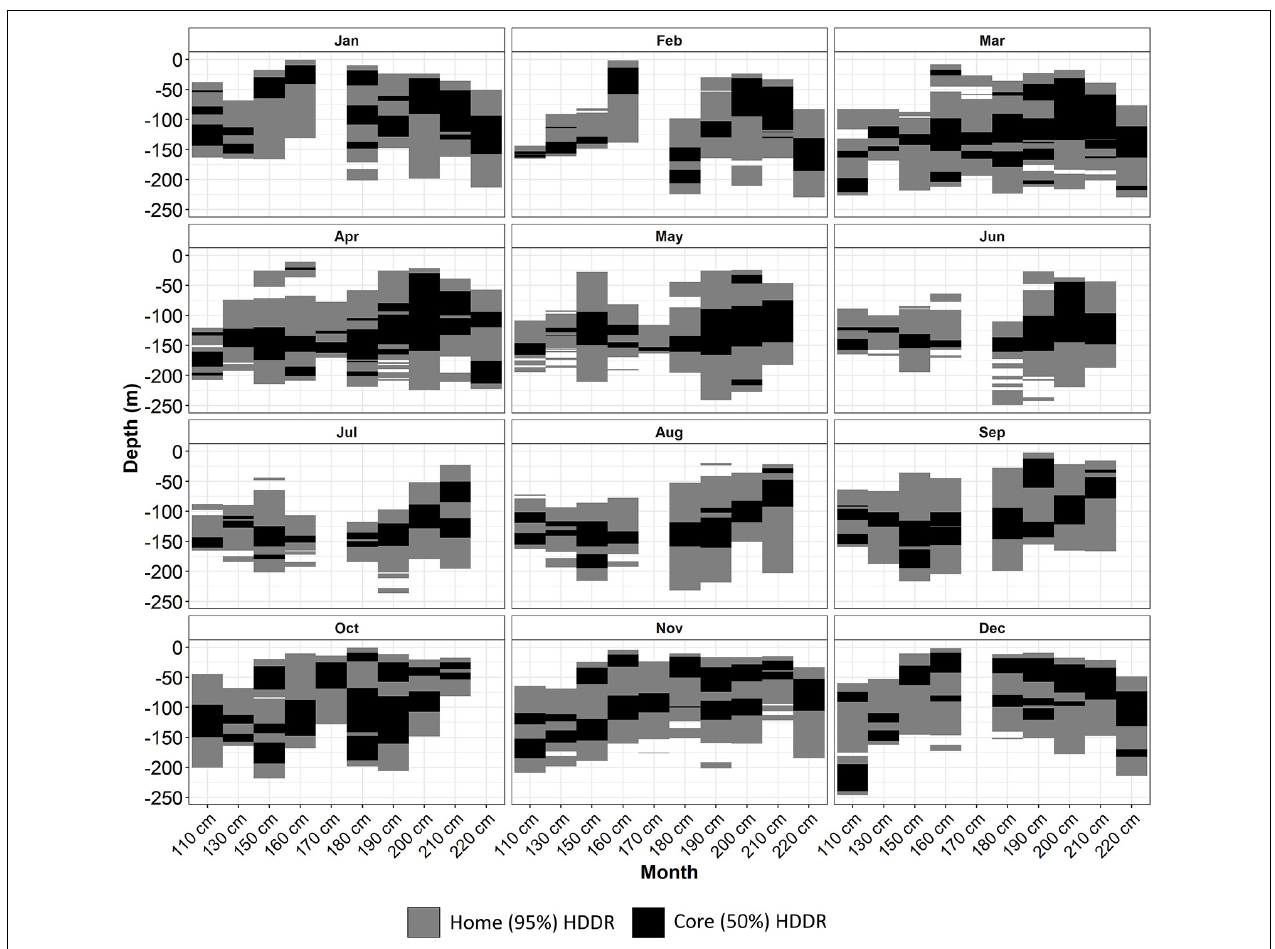
FIGURE 6 | Home (95%) and core (50%) monthly highest density depth regions (HDDRs) for each 10-cm length class of skate.